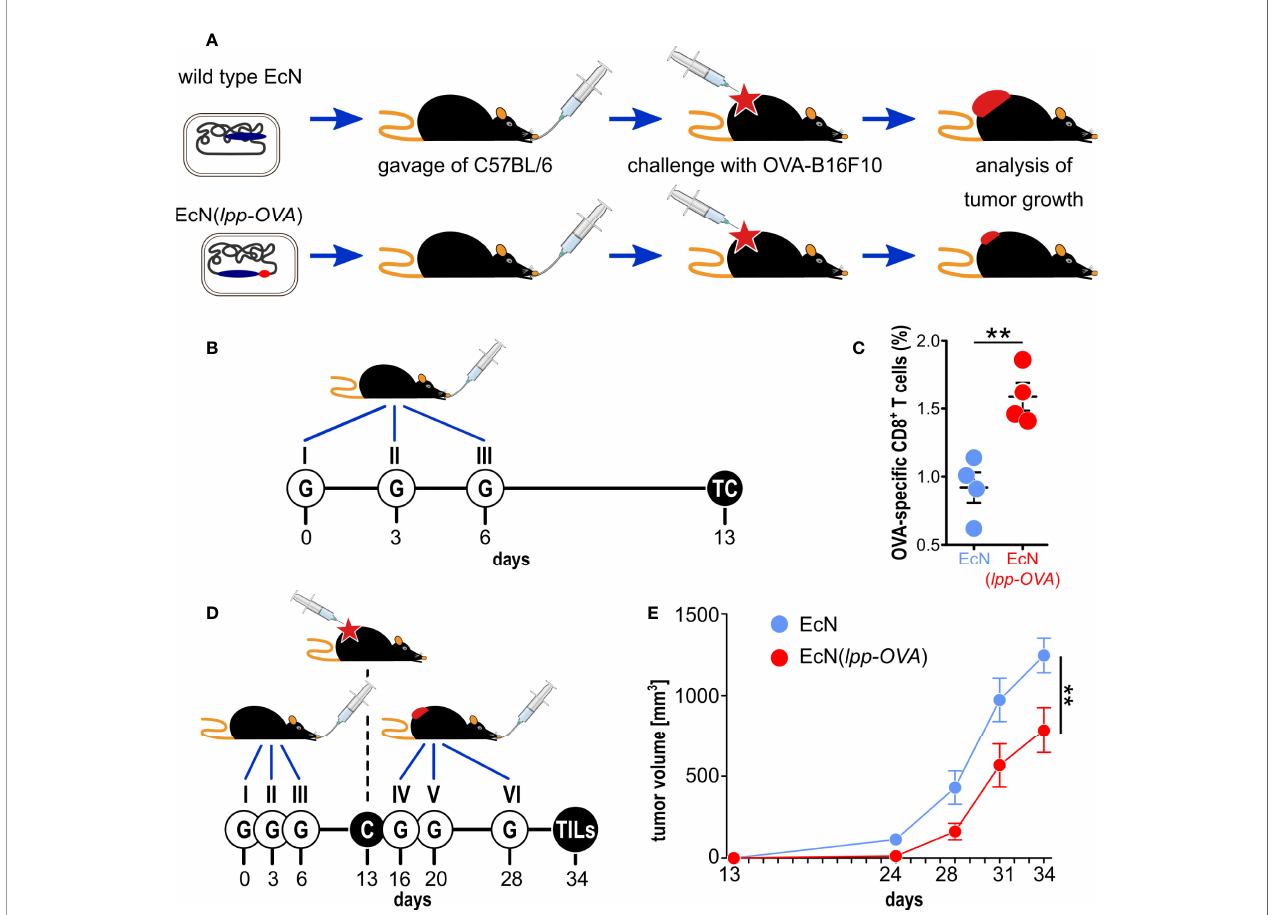
FIGURE 1 | Testing the role of molecular mimicry in tumor inhibition by oral administration of engineered probiotic bacteria. (A) Schematic representation of the experimental strategy used to support the role of “ molecular mimicry ” in tumor inhibition . E. coli Nissle was engineered with the OVA CD8 + T cell epitope and the strain, or w.t. E. coli Nissle , were given to C57BL/6 mice by oral gavage. Animals were subsequently challenged with OVA-B16F10 cells and tumor growth was followed over time. (B) Experimental setup for the analysis of OVA-speci fi c T cells in the lamina propria . 10 9 CFU of EcN and EcN( lpp-OVA ) were given to C57BL/6 mice three times at three day intervals by gavage ( “ G ” ). One week after the last gavage, T cells ( “ TC ” ) were isolated from the lamina propria and OVA-speci fi c CD8 + T cells were analyzed by fl ow cytometry. (C) Flow cytometry analysis of OVA-speci fi c CD8 + T cells in lamina propria – 1.5x10 6 cells were extracted from the lamina propria of C57BL/6 mice treated with EcN (blue) and EcN( lpp-OVA ) (red) as described in (B) . The frequency of OVA-speci fi c CD8 + T cells was measured by using OVA 257-264 Dextramer-PE. Data from one single experiment (4 mice per group) (D) Experimental setup to test tumor inhibition of by oral administration of EcN(lpp- OVA) . EcN and EcN( lpp-OVA ) were given at three day intervals to C57BL/6 mice by oral gavage ( “ G ” ). One week after the third gavage, mice were challenged ( “ C ” ) with 2.8×10 5 OVA-B16F10 cells followed by three additional gavages. Tumor growth was followed over a period of 23 days and at the end of the experiment tumor in fi ltrating T cells (TILs) were analyzed. (E) Analysis of tumor inhibition by EcN(lpp-OVA) . Animals were treated as depicted in D, and tumor volumes were measured over time. Animals were sacri fi ced when tumors reach a volume of 1.500 mm 3 . Combined data from two independent experiments (17 and 18 mice in control and vaccinated group, respectively). Statistical analysis was performed using Student ’ s t-test (two-tailed). **P ≤